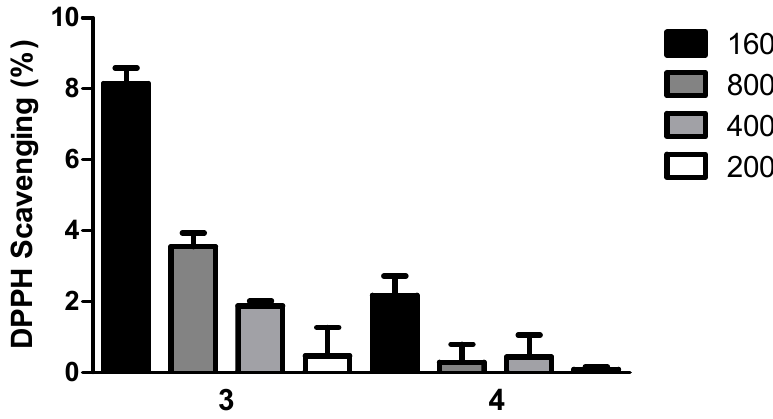
Figure 1. Radical scavenging ability of selected cinnamylideneacetophenones. DPPH = 2,2-diphenyl- 1-picrylhydrazyl.